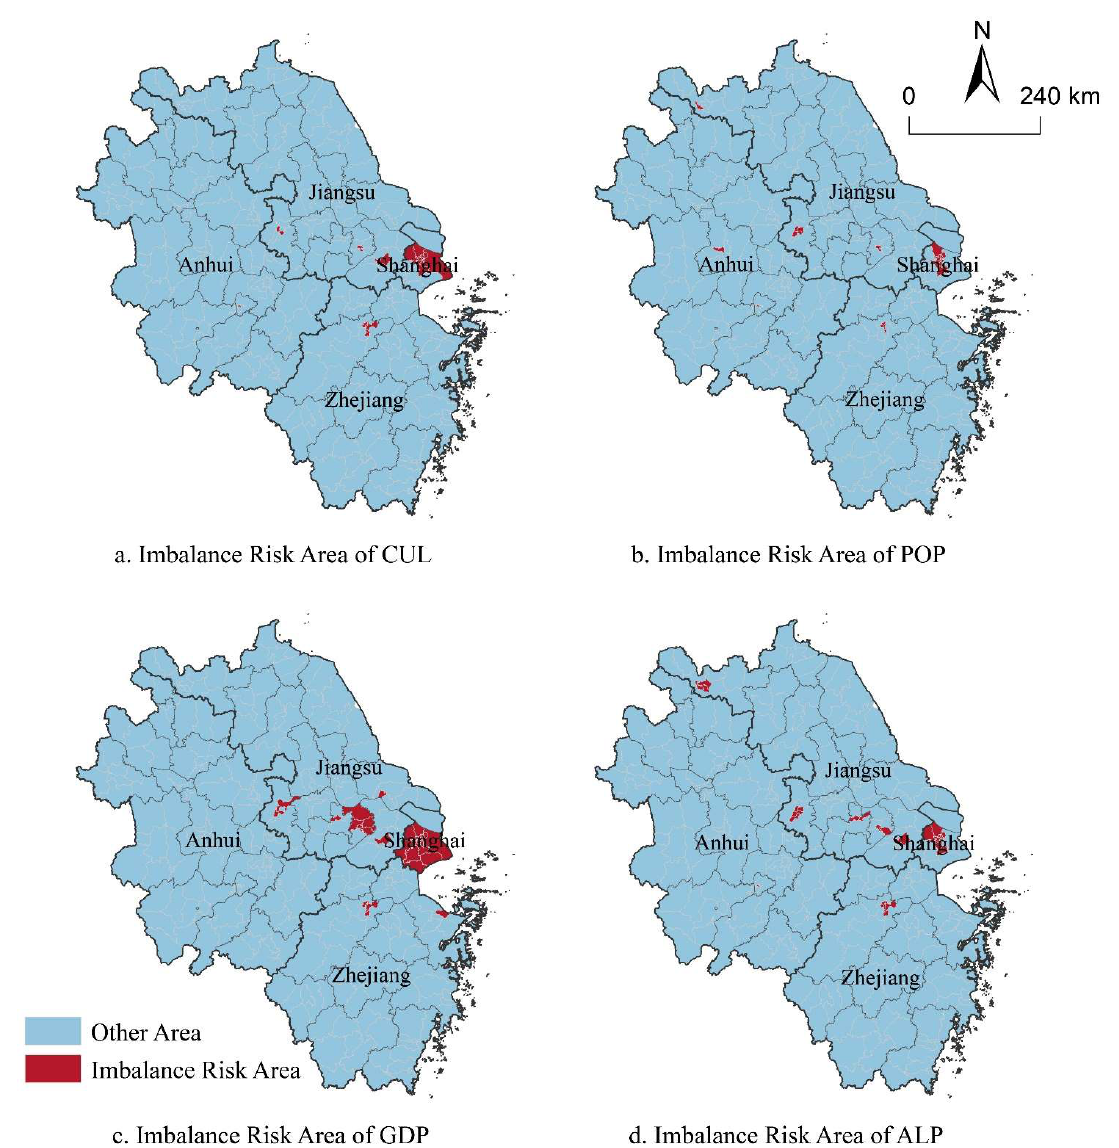
Figure 11. Risk areas of imbalanced CSD under different urbanization drivers.